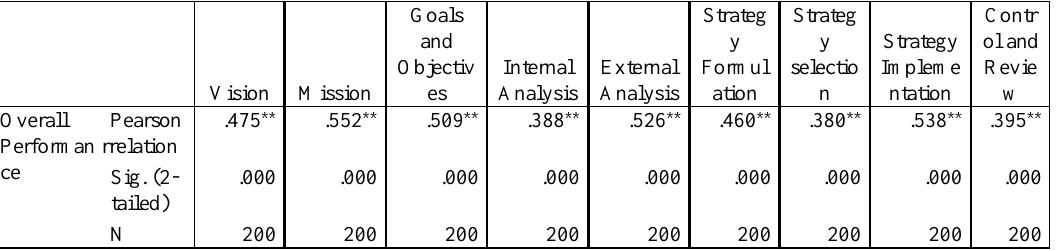
Table 6: Relationship between each Step of the Strategic Planning Process and Business